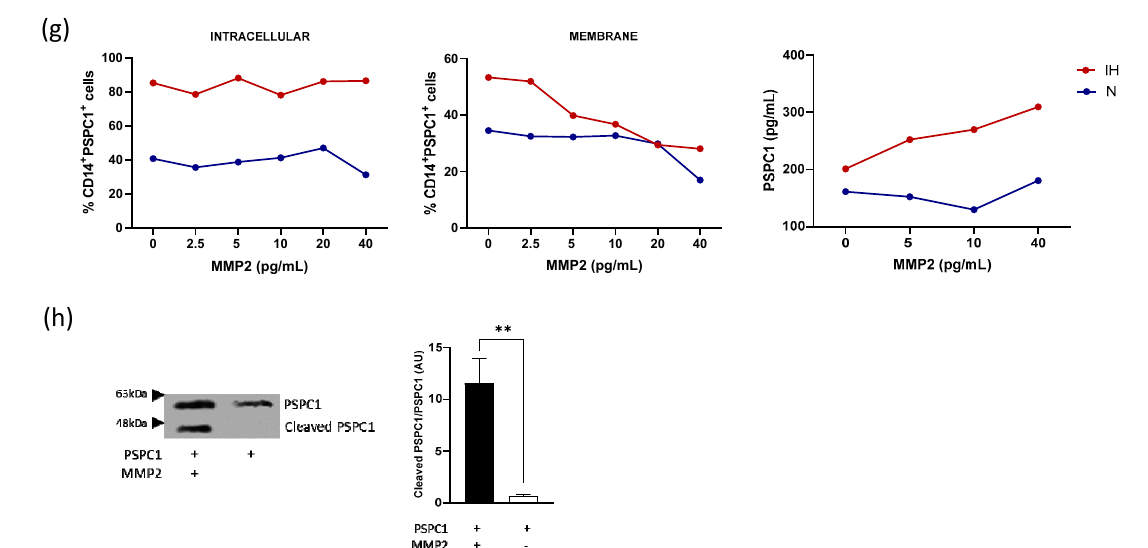
Figure 1. PSPC1 expression and its cleavage in patients with OSA. ( a ) The mean fluorescence intensity (MFI) of the monocyte PSPC1 intracellular expression (as determined by flow cytometry) in HV ( n = 8) and the patients with severe OSA ( n = 15) are shown. The PSPC1 distribution ( left panel) and PSPC1 histogram ( right panel) are shown; ( b ) The monocytes PSPC1 mRNA expression (estimated by qPCR) in the monocytes from HV ( n = 23) and the patients with severe OSA ( n = 50) are shown; ( c ) The PSPC1 plasma protein was quantified using ELISA ( n = 18 HV and n = 45 patients with severe OSA). The intergroup differences in PSPC1 expression were assessed using an unpaired t -test with Welch’s test correction. Error bars: Standard error of the mean (SEM). * p < 0.05, ** p < 0.01 when compared with HV; ( d ) Correlation between PSPC1 and TGF β mRNA expression in the monocytes from the patients with severe OSA ( n = 45) ( left panel) and the correlation between PSPC1 and TGF β protein concentration in the plasma of the patients with severe OSA ( n = 40) ( right panel). The patients were randomly selected. Spearman correlation coefficients (r) and p -values are shown; ( e ) Correlation between MMP2 and PSPC1 mRNA expression in the monocytes from the patients with severe OSA ( n = 45) ( left panel) and the correlation between MMP2 and PSPC1 protein concentration in the plasma of the patients with severe OSA ( n = 40) ( right panel). Pearson’s correlation coefficients (r) and p -values are shown; ( f ) MMP2 mRNA expression analysis by qPCR in the monocytes from HV ( n = 18) and the patients with severe OSA ( n = 45) ( left panel). The MMP2 protein was quantified using ELISA ( n = 20 HV, and n = 40 patients with OSA) ( right panel). The groups were compared using an unpaired t -test with Welch’s test correction. Error bars: SEM. * p < 0.05, **** p < 0.0001 as compared with HV; ( g ) The PSPC1 expression by flow cytometry analysis is shown. Monocytes from HV ( n = 3) were cultured under normoxia or IH for 24 h and then treated with MMP2 for 3 h ( left and middle panels). Supernatants were collected to evaluate PSPC1 protein concentrations using ELISA ( right panel). Mean values are shown. Spearman coefficients (r) and p -values ( p ) were calculated for the left panel N (r = 0.3143, p = 0.5639) and IH (r = − 0.02, p = >0.99) and right panel N (r = − 0.8286, p = 0.0583) and IH (r = − 1.00, p = 0.0028); ( h ) Western blot analysis of enzymatic digestion of PSPC1 with or without MMP2 (molar ratio of 1:10) is shown ( left panel). The expected size of 59 kDa (uncleaved) and an additional band of approximately 43 kDa (cleaved) were observed. Three different experiments were performed with similar findings ( right panel). The comparison was performed by unpaired t -test; ** p <